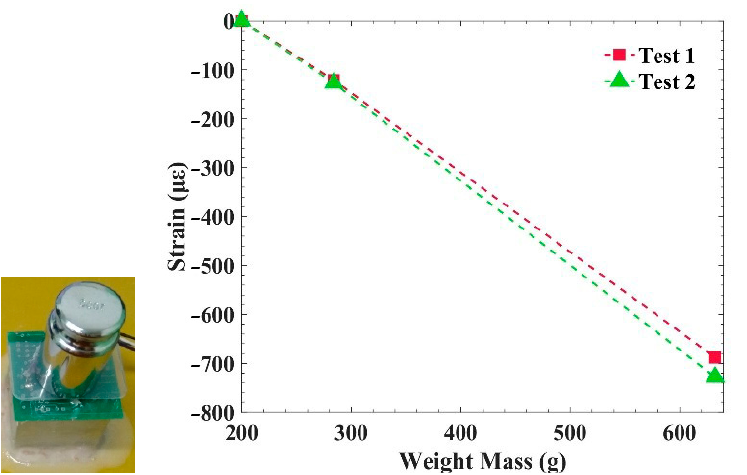
Figure 4. Influence of additional force on PCB strain.